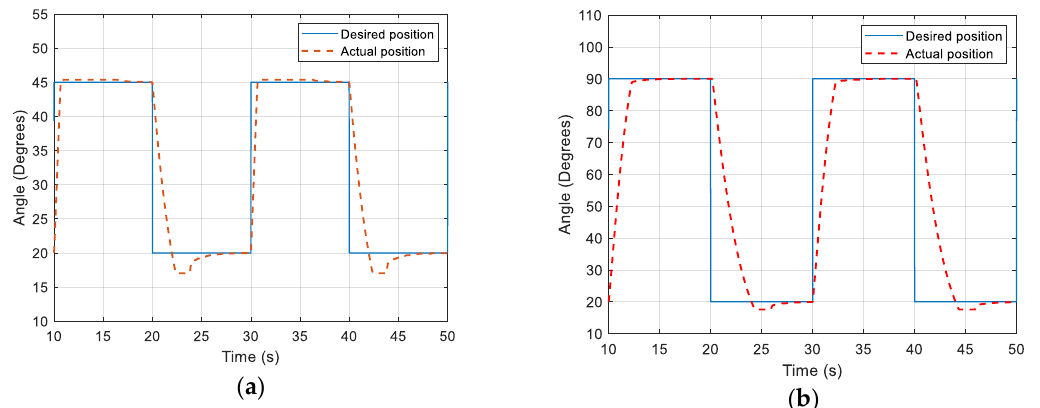
Figure 12. Simulated actual and desired positions of the soft finger with a pulse driven input (pulse period = 20 s). ( a ) The pulse input from 20 ◦ to 45 ◦ . ( b ) The pulse input from 20 ◦ to 90 ◦